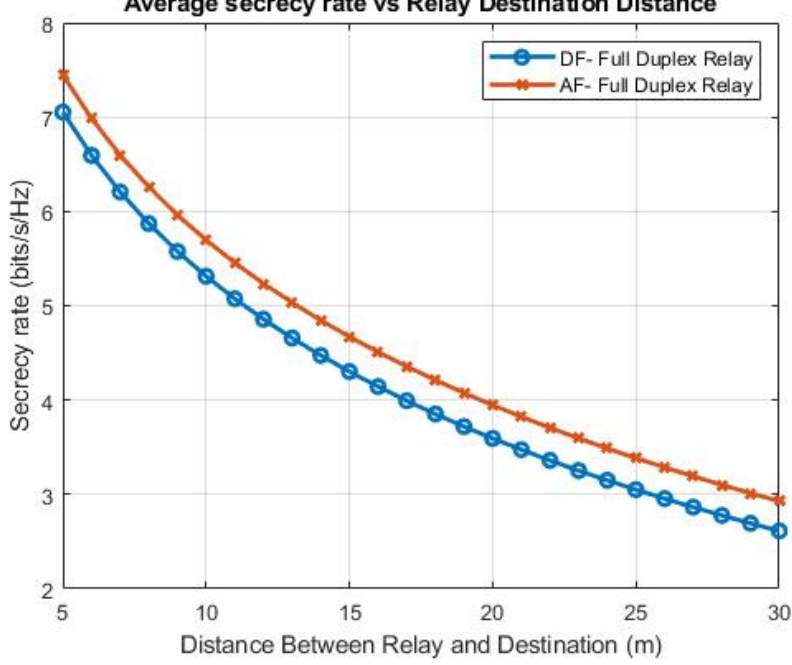
Figure 8. Secrecy Rate vs d R 2 D for the proposed EH PS System.